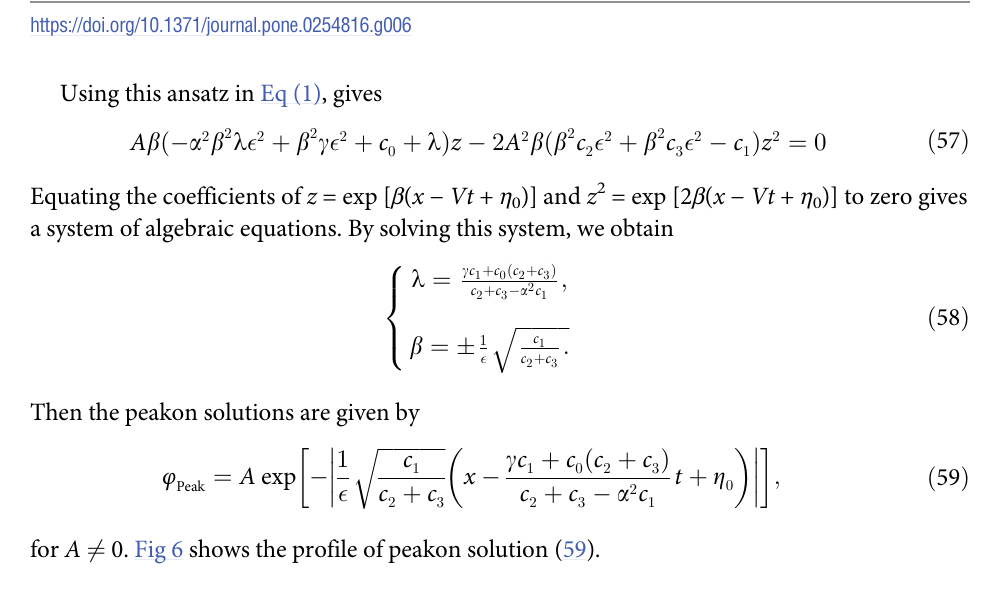
Fig 6. Profile of peakon solution (59) is plotted in the plane ( x , t ) for α = 1, γ = 0, ε = 1, c 0 = c 2 = 1, c 1 = 3, c 3 = 5 c 2 , and η 0 =